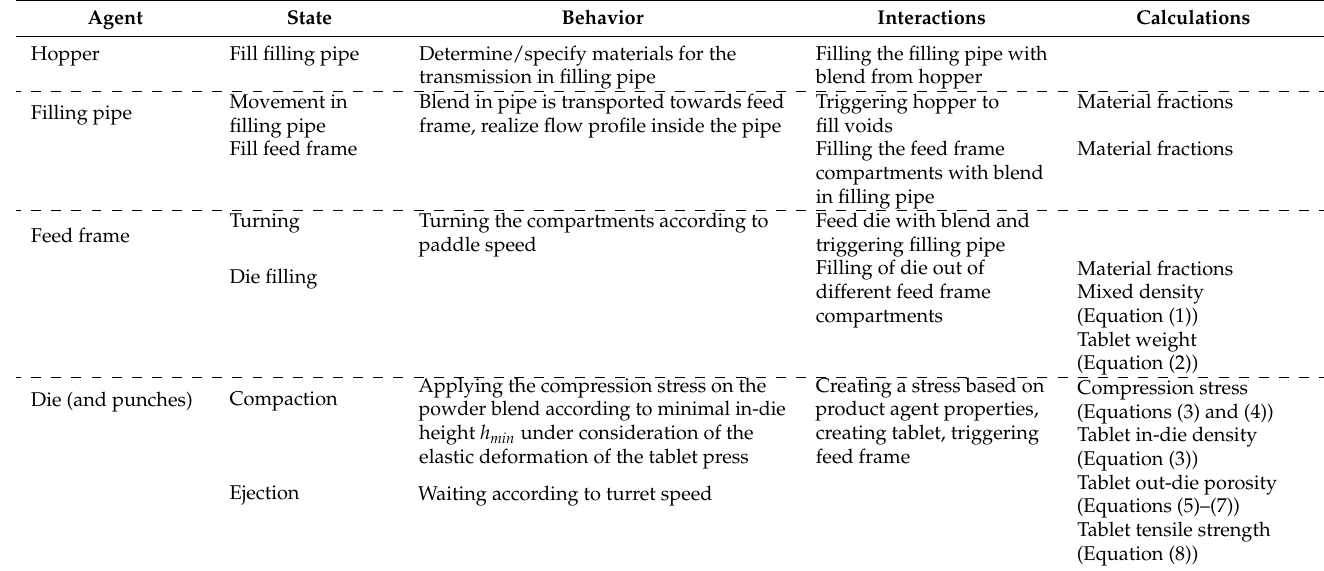
Table 2. Overview of the states of rotary press process agents, their behaviors, and their interactions.